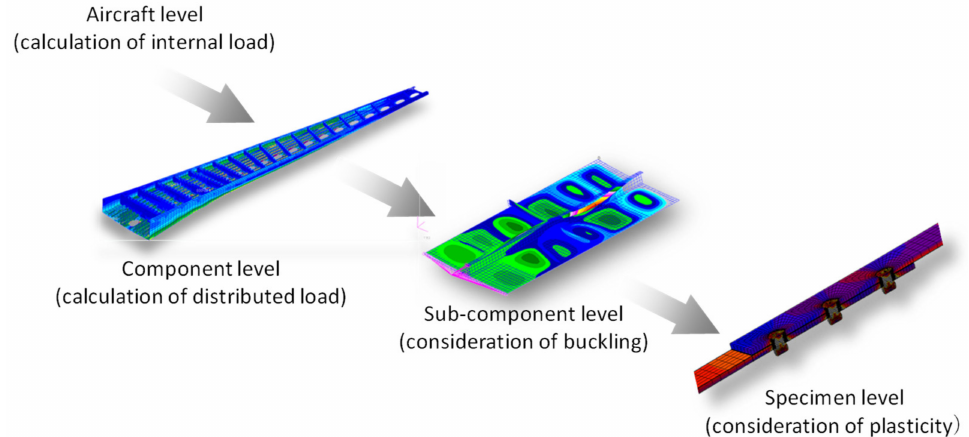
Figure 1. Practical finite element analyses for the design of an aircraft structure.